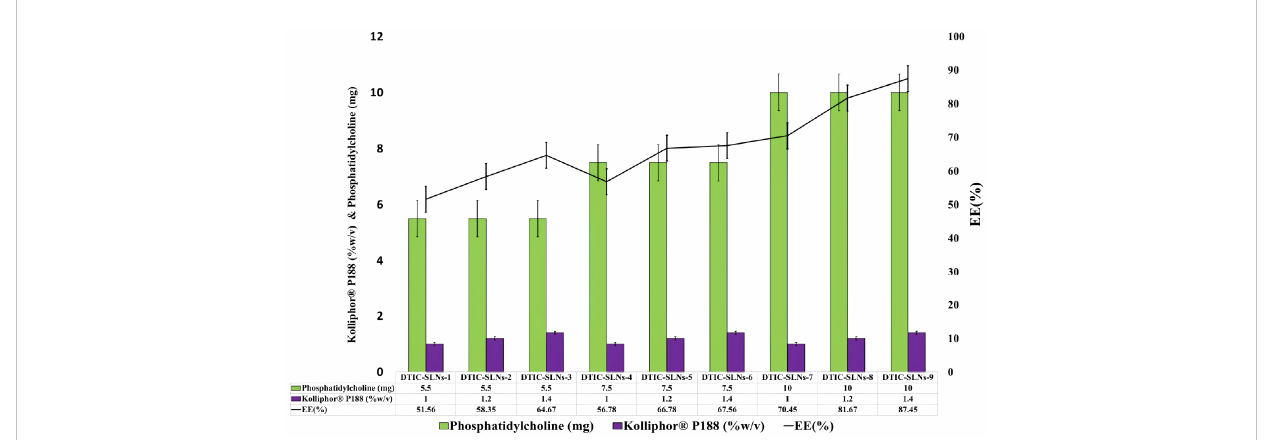
FIGURE 1 Phosphatidylcholine (mg) and Kolliphor ® P188 (w/v%) impact on encapsulation ef fi cacy percentage were